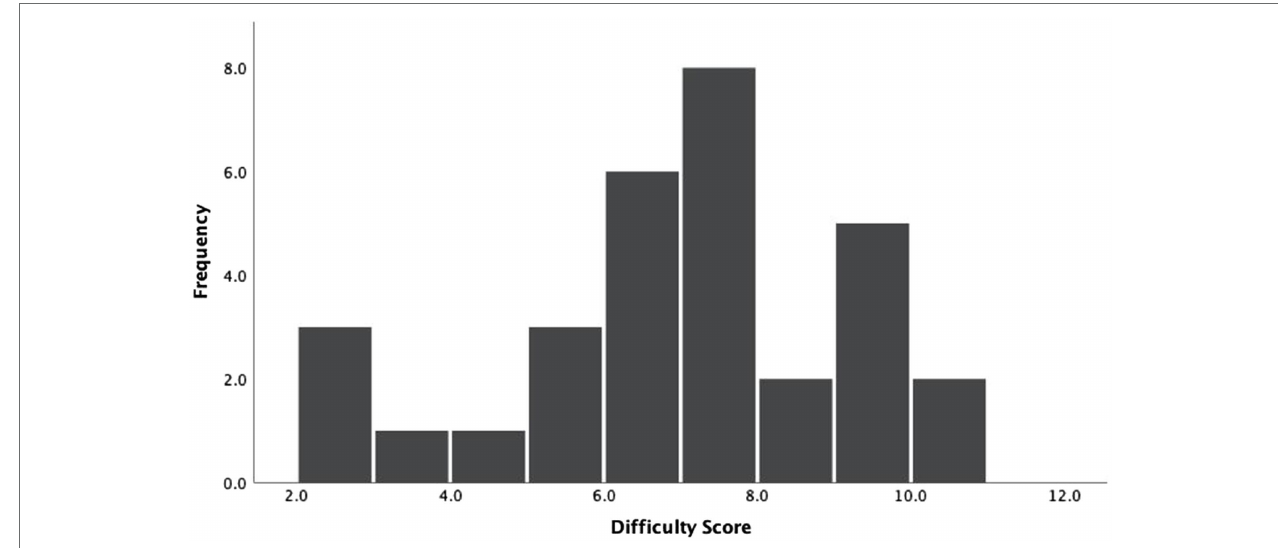
FIGURE 3 | Distribution of difficulty scores across